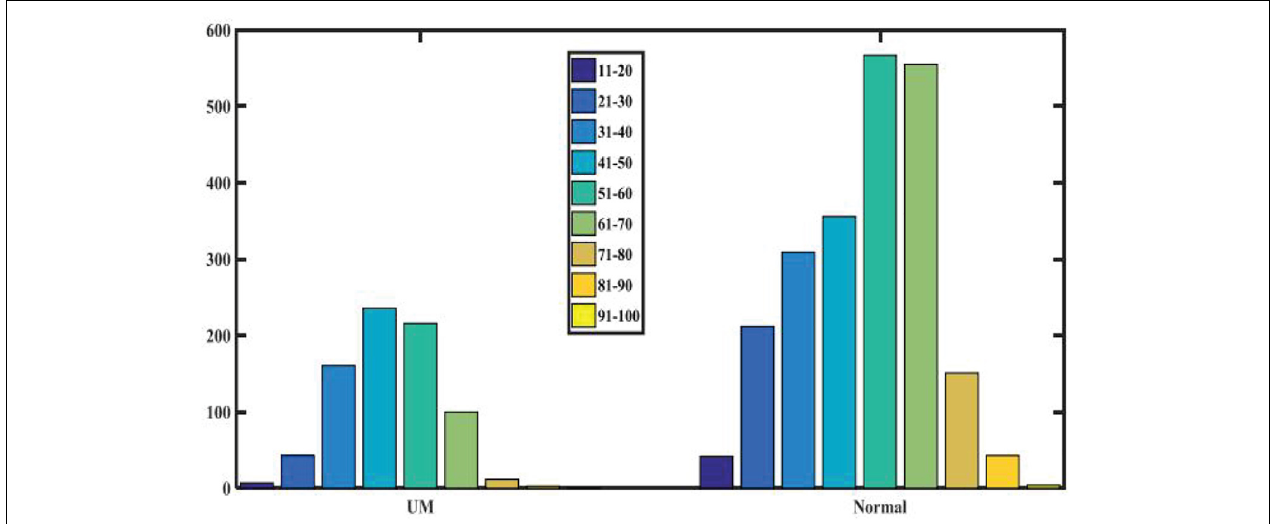
FIGURE 3 | Age distribution of patients in the two